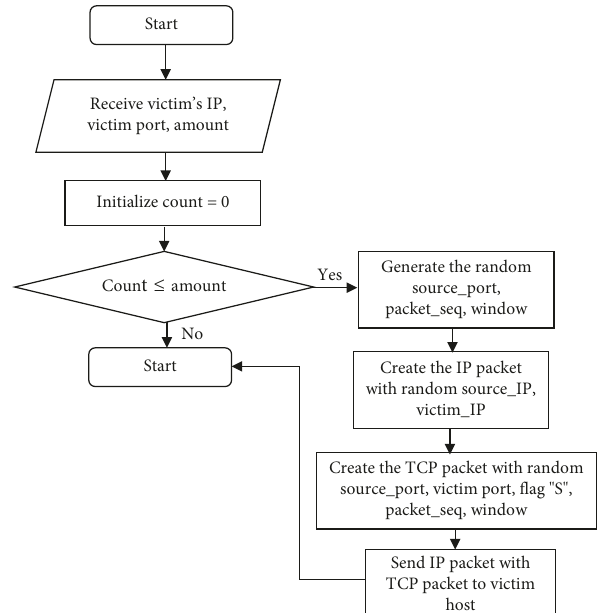
Figure 5: Step by step process of SYN Flooding Attack.